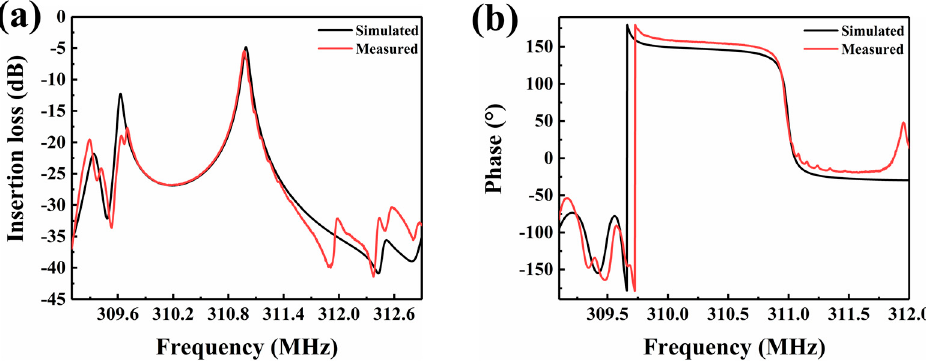
Figure 5. The contrast of the theoretical results and measured results: ( a ) Amplitude-frequency response; ( b ) Phase-frequency response.